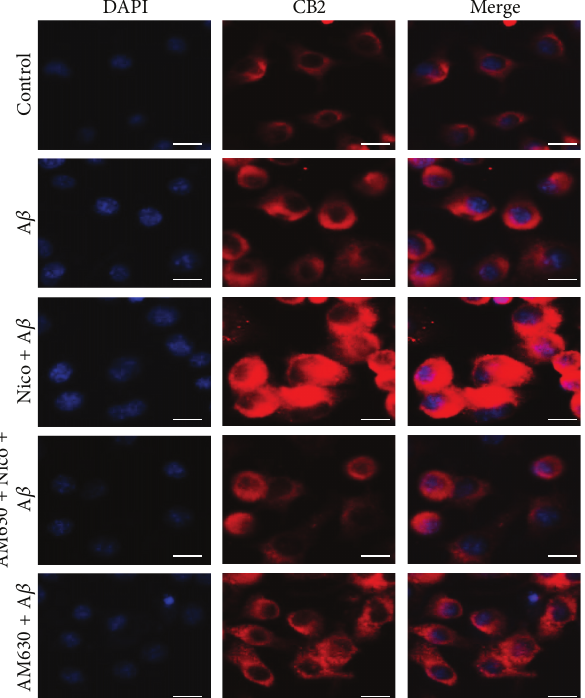
Figure 2: Nicotine increased CB2 receptor expression in microglial cells exposed to A 𝛽 . The microglial cells were divided into five groups: control: cells cultured in drug-free medium; A 𝛽 : cells cultured in the medium containing 5 𝜇 M A 𝛽 ; nicotine (Nico) + A 𝛽 : cells cultured in the medium containing 10 𝜇 M nicotine and 5 𝜇 M A 𝛽 ; AM630 + Nico + A 𝛽 : cells cultured in the medium containing 10 𝜇 M CB2 antagonist AM630,10 𝜇 Mnicotine,and5 𝜇 MA 𝛽 ;AM630+A 𝛽 :cellsculturedinthemediumcontaining10 𝜇 MAM630and5 𝜇 MA 𝛽 .Afteranincubation of 24 h, immunocytochemistry was used in investigating CB2 receptor expression (red), and the nuclei (blue) were counter-stained with DAPI staining solution. Bar = 20 𝜇